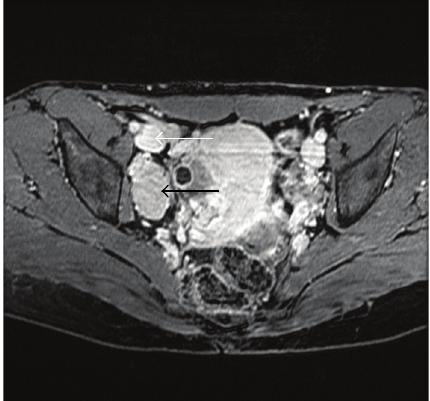
Figure 2: Pelvic magnetic resonance imaging: axial GE-T1 fat sat with gadobenate dimeglumine in venous phase shows intense enhancement (black arrow), similar to the vessels (white arrow).